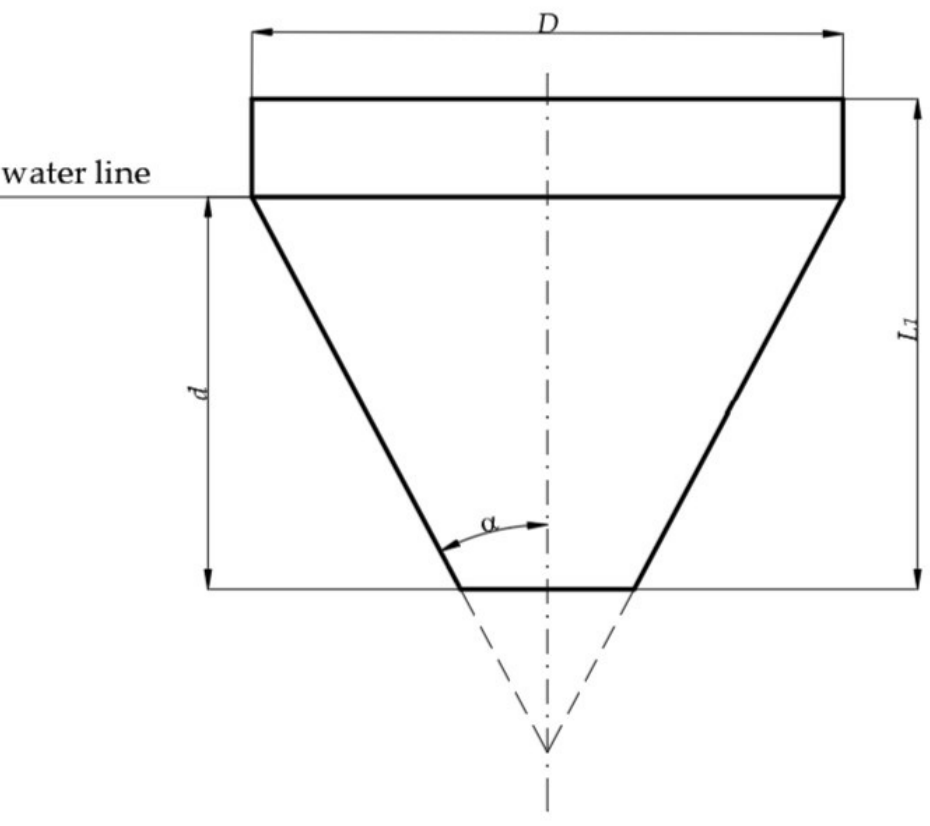
Figure 4. Schematic of the floating body’s structure. For each simulation, the given frequency range is divided into 52 frequency points. The mean power for each sample at each frequency is calculated. The results of sample 1 and sample 2 are shown in Figure 5. With the increase in wave frequency, the capture power rises firstly and then drops steadily. For each sample, there is a unique optimal frequency in which the capture power can reach the maximum. The 100 samples’ capture power are calculated so that they can be used as training set and test set for BP neutral network. Only two samples’ results are presented in this